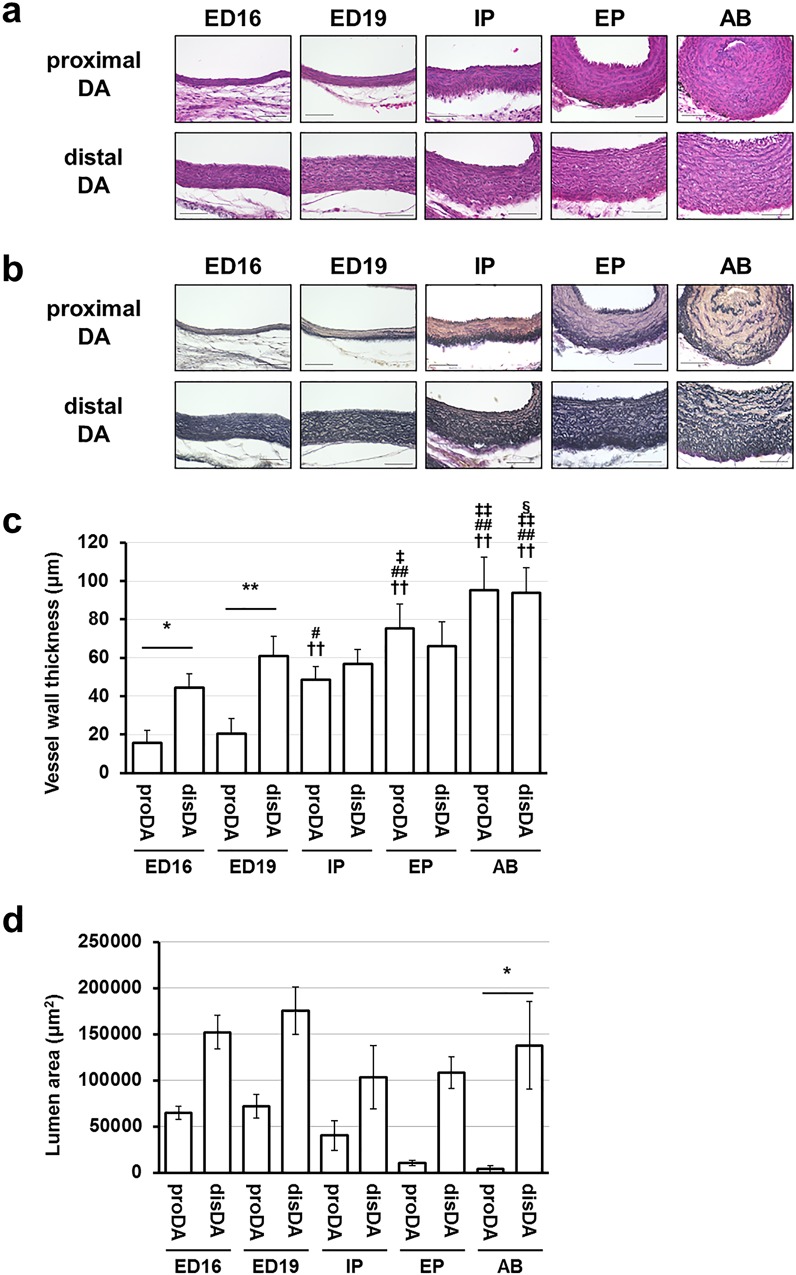
Distinct morphological changes in the proximal portions of the chick DA during development.Representative histological sections of the proximal and distal DA from ED16 to AB. Serial sections were stained with HE (a) and EVG staining (b). (a) The nucleus in the middle lamella of the distal DA were aligned in parallel to the internal elastic laminar and layered throughout the hatching, whereas the layers were disorganized in the proximal DA from the IP stage. Scale bars are 50 μm. (b) The proximal DA and the distal DA had a muscular and an elastic type of artery, respectively. Moreover, in the proximal DA, the poor elastic fiber formation was observed in the middle lamella from the IP stage. Scale bars are 50 μm. (c) The vessel wall thickness of the chick DA at developmental stages. The vessel wall of the proximal DA was thin compared to the distal DA at the ED16 and ED19 stage. Moreover, the vessel wall of the proximal DA drastically thickened from the ED19 to the IP stage. * and ** indicate p < 0.05 and p<0.01, †† indicates p<0.01 compared to the same tissues of the ED16 stage, # and ## indicate p < 0.05 and p<0.01 compared to the same tissues of the ED19 stage, ‡ and ‡‡ indicate p < 0.05 and p<0.01 compared to the same tissues of the IP stage, § indicates p<0.05 compared to the same tissues of the EP stage, n = 4–5. (d) The vessel luminal area of the chick DA at developmental stages. * indicates p < 0.05. n = 4–5.